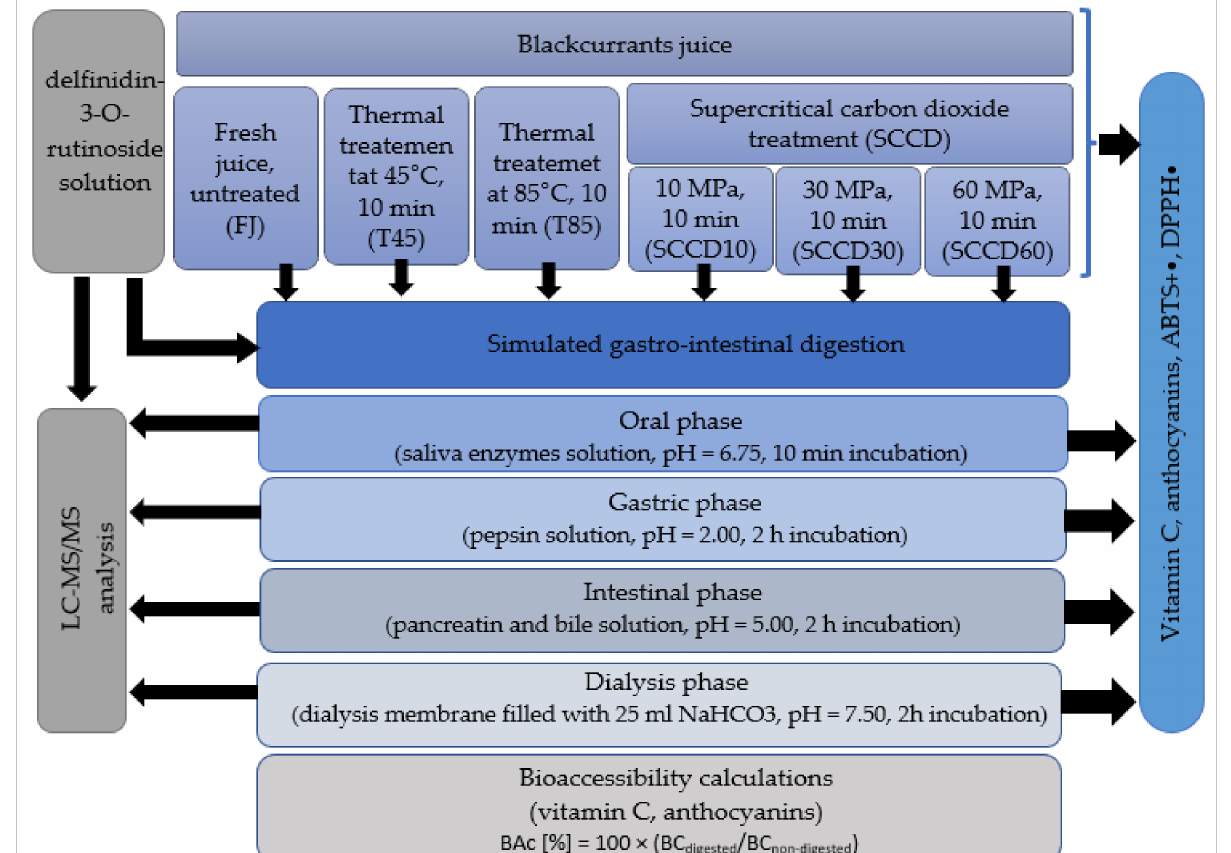
Figure 1. A schematic diagram showing the work flow described in this